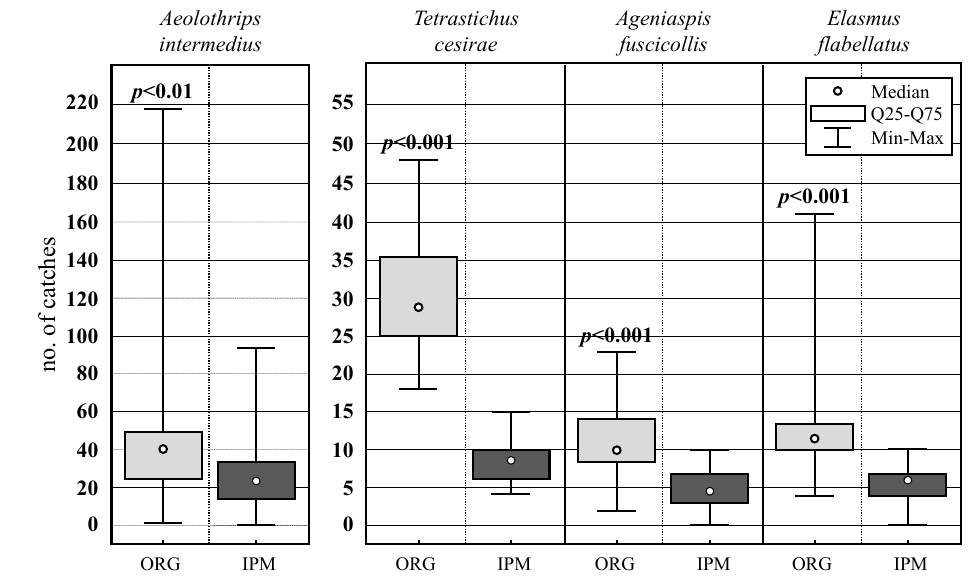
Figure 4. Statistic capture values (median, quartile 25, quartile 75, maximum, and minimum) of the major beneficial species in the control plots of organic (light color) and IPM (dark color) olive groves. The level of statistical significance obtained from the Mann–Whitney U test is also indicated ( p value).